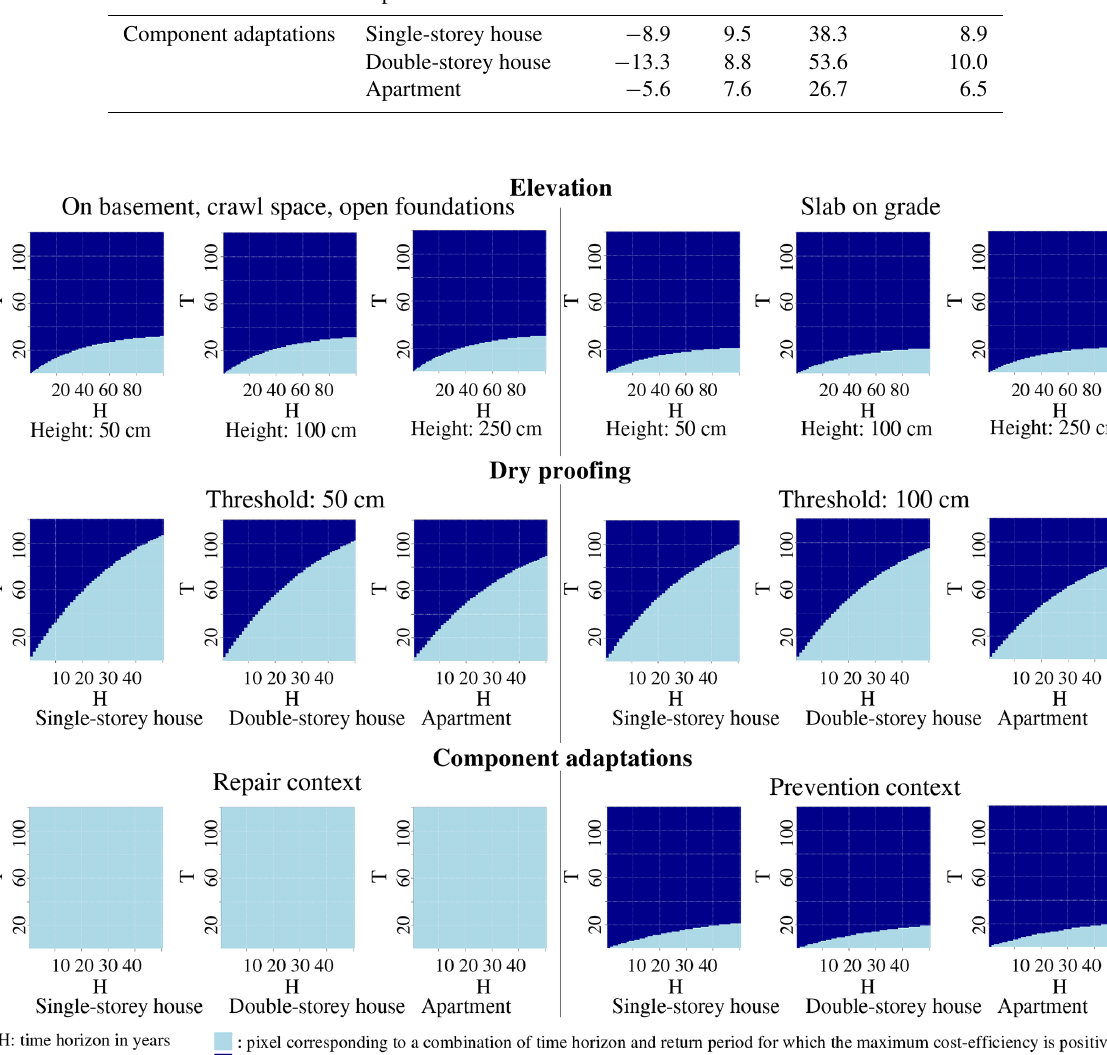
Figure 4. Sign of the maximum cost-efficiency of each